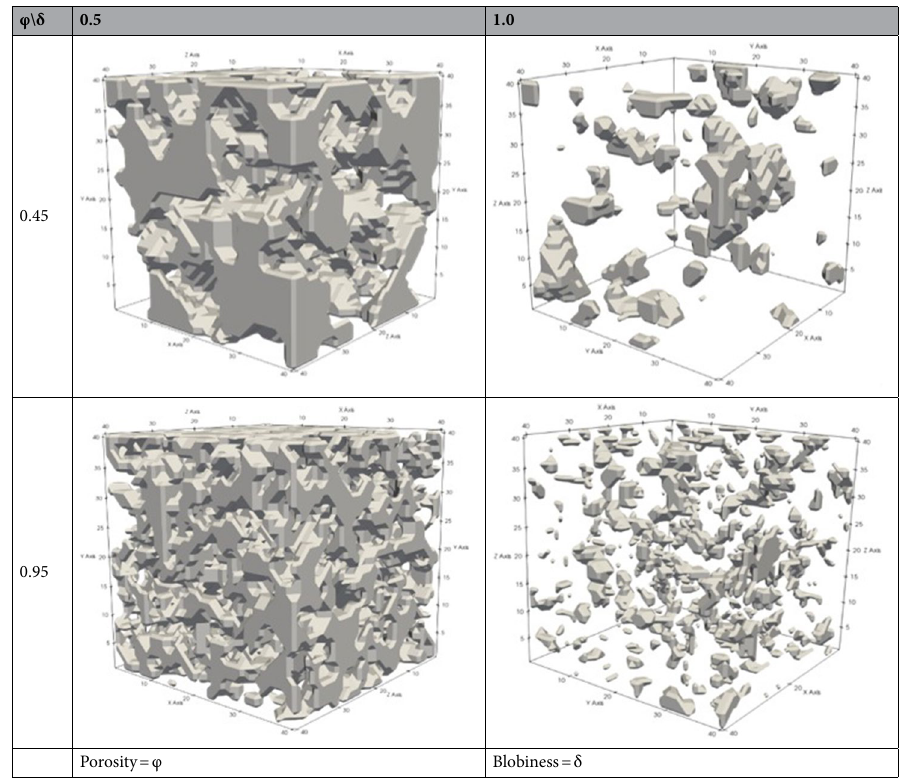
Table 1. 3-D Rendering of artificial porous media for this study. Minimum and maximum values of porosity and blobiness are considered.